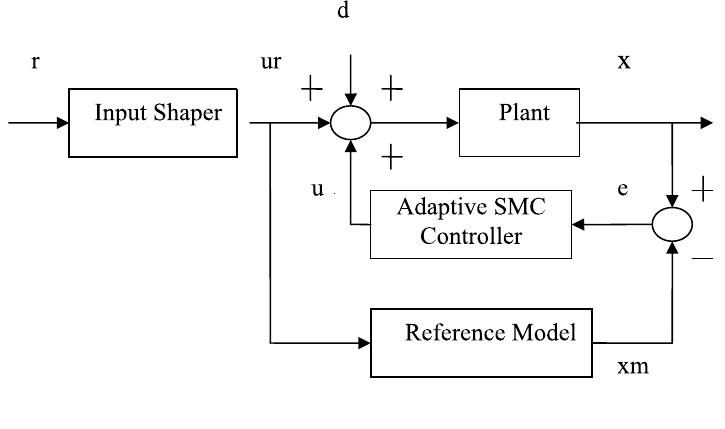
Fig. 1. Proposed control